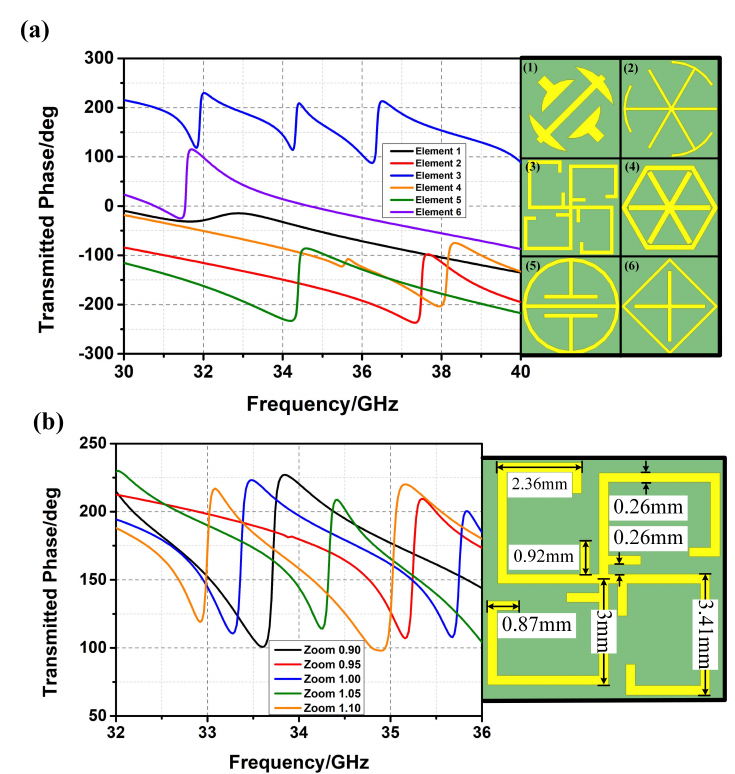
Figure 2. ( a ) Metamaterial elements with different transmission phases; ( b ) fractal metamaterial element with different zoom coefficients.